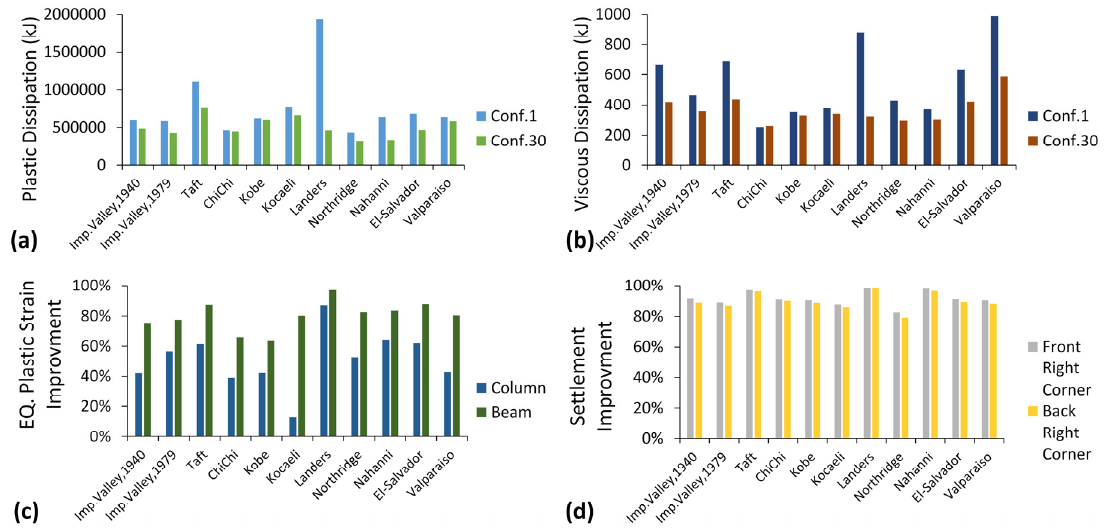
Figure 19. Parametric comparison: ( a ) plastic dissipation, ( b ) viscous dissipation, ( c ) equivalent plastic strain improvement, and ( d ) settlement at the top of the structure.